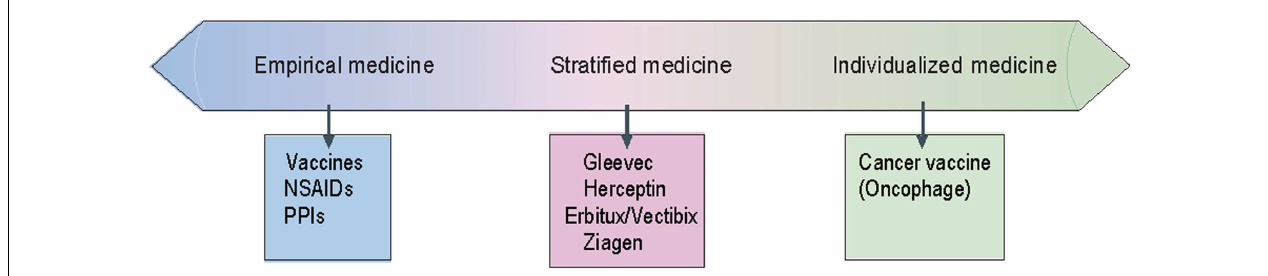
FIGURE 1 | Stratified medicine diagram (adapted from:Trusheim et al., 2007,The patient therapeutic continuum).